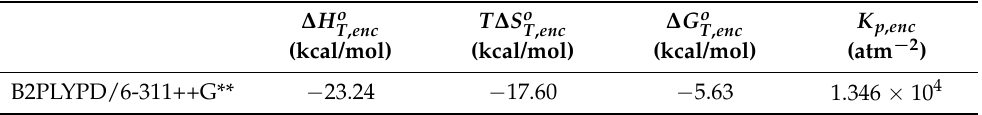
, entropy T ∆ S o , Gibbs energy ∆ G o changes, and the T , enc T , enc T , enc ∆ H o T ∆ S o T , enc T ,